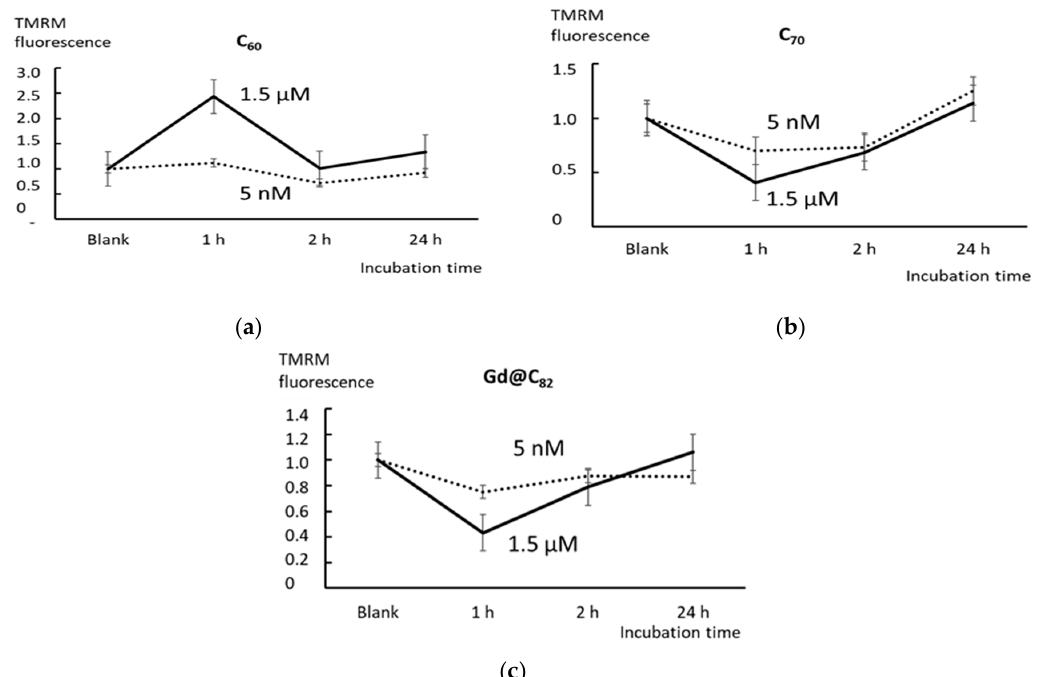
Figure 3. The mitotracker test with TMRM using flow cytometry: the relative enhancement of the mitotracker signal in cells relative to the blank versus incubation time with C 60 ( a ), C 70 ( b ), and Gd@C 82 ( c ). In blank experiments, cells were incubated without AFDs. Concentrations are indicated in the figure.